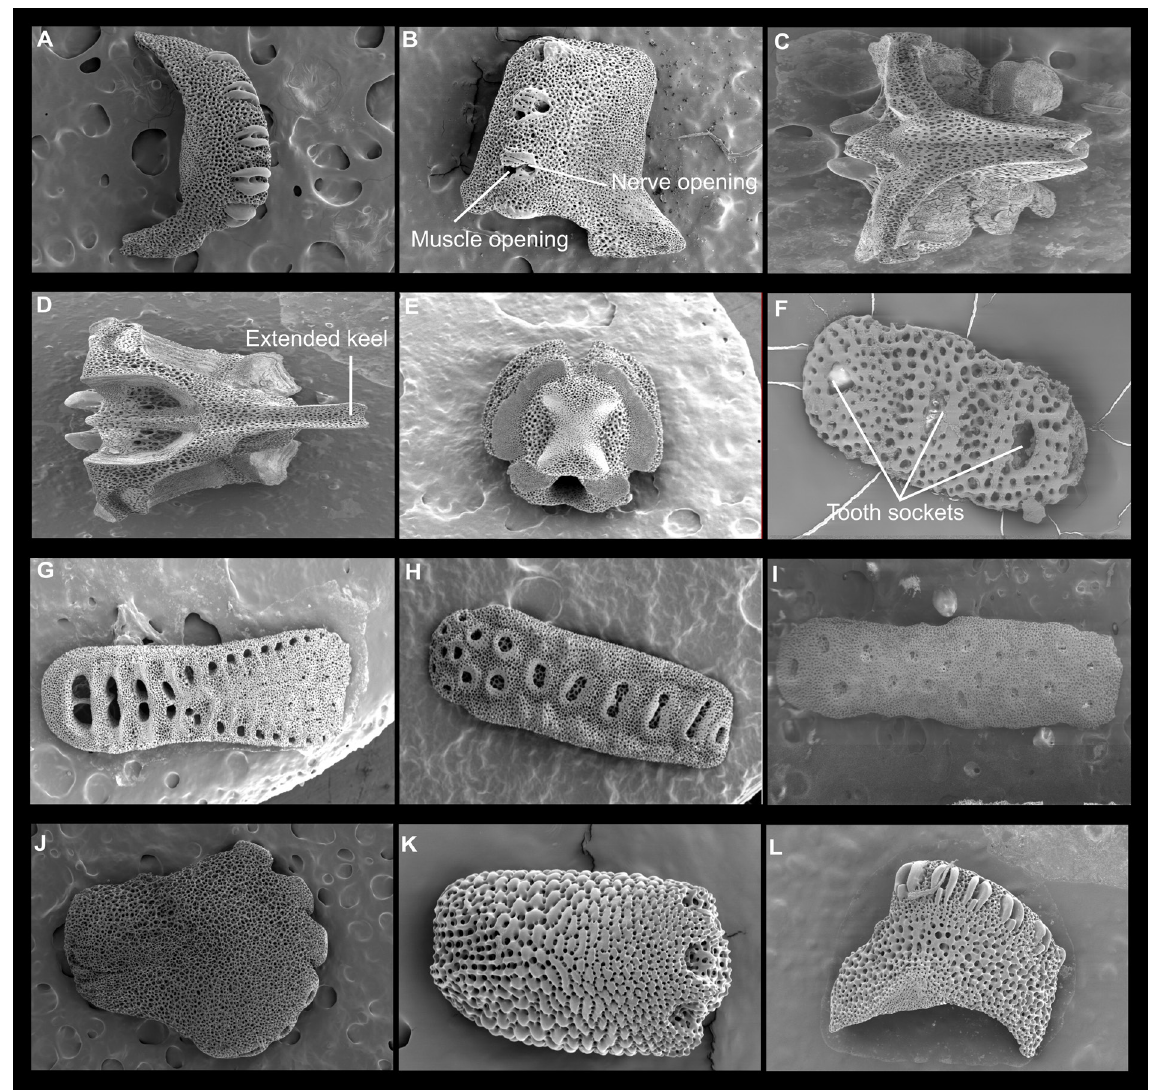
Fig. 3. SEM images of various ossicle structures in brittle stars. A . Muscle and nerve opening on LAP separated by small ridge if at all ( Amphiura chiajei Forbes, 1843). B . Muscle and nerve opening on LAP separated by large, prominent ridge or regular stereom ( Ophiolycus purpureus (Düben & Koren, 1846)). C . Non-keeled vertebra ( Amphiura chiajei ). D . Keeled vertebra ( Ophiothrix fragilis Abildgaard, 1789). E . Vertebra with oral bridge ( Euryale aspera Lamarck, 1816). F . Sockets indicate teeth and tooth papillae on dental plate as single row ( Amphilepis norvegica (Ljungman, 1865)). G . ½ single row of teeth and ½ tooth papillae ( Ophiothrix fragilis ). H . ⅔ single row of teeth and ⅓ tooth papillae ( Ophiocamax vitrea Lyman, 1878). I . Sockets on dental plate covering evenly ( Asteronyx loveni Müller & Troschel, 1842). J–K . LAP not arched = position lateral. L . LAP arched = wrapped around the